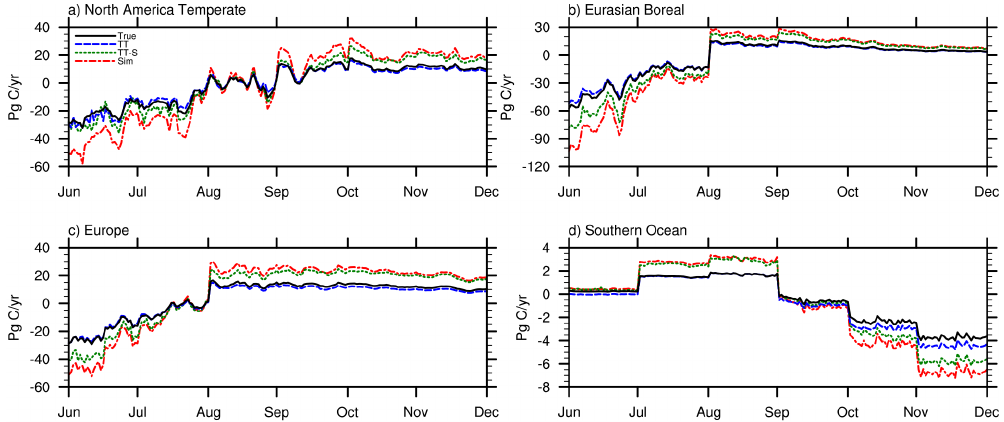
Figure 8. Time series of the daily mean CO 2 surface fluxes from the “truth”, simulations, TT-S (the simplified version of Tan-Tracker) and TT (Tan-Tracker) assimilations aggregated to the selected four TransCom regions (i.e., CT-02, CT-07, CT-11 and CT-20) during the period from 1 July to 31 December 2010.